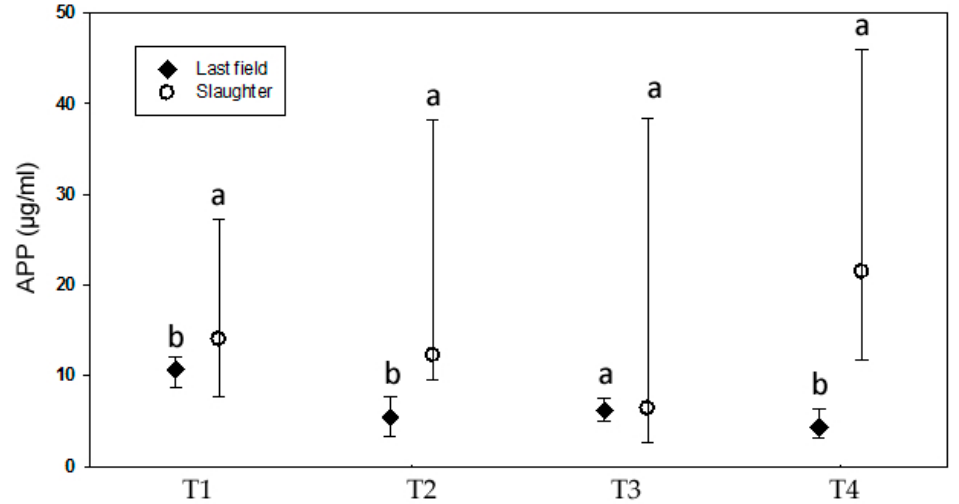
Figure 6. Last field and slaughter APP serum concentration within each treatment. Lines represent the median, 25th, and 75th percentile values. a,b Medians within the same treatment with different letters differ with p < 0.05.